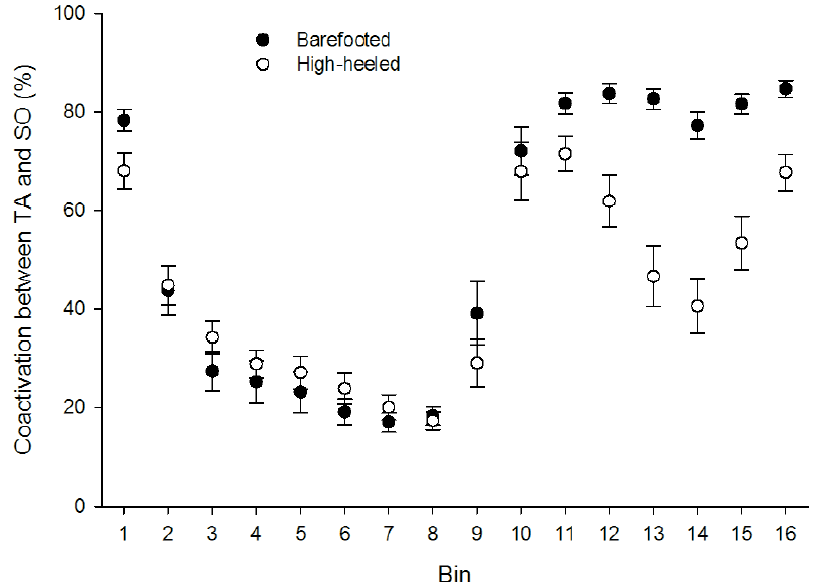
Figure 6. Level of coactivation between the SO and TA muscles. The coactivation was calculated as the relative contribution of the TA EMG to the total sum of the SO and TA EMG in each of the 16 bins representing the gait cycle. If the coactivation value approaches 50% the muscles contribute equally to the total amount of EMG activity indicating indicating maximal coactivation. 100% indicates that TA is active and SO silent while 0% indicates that the SO is active and the TA silent. Coactivation values of the high-heeled (open circles) and barefooted (filled circles) walking are means 6 SE.